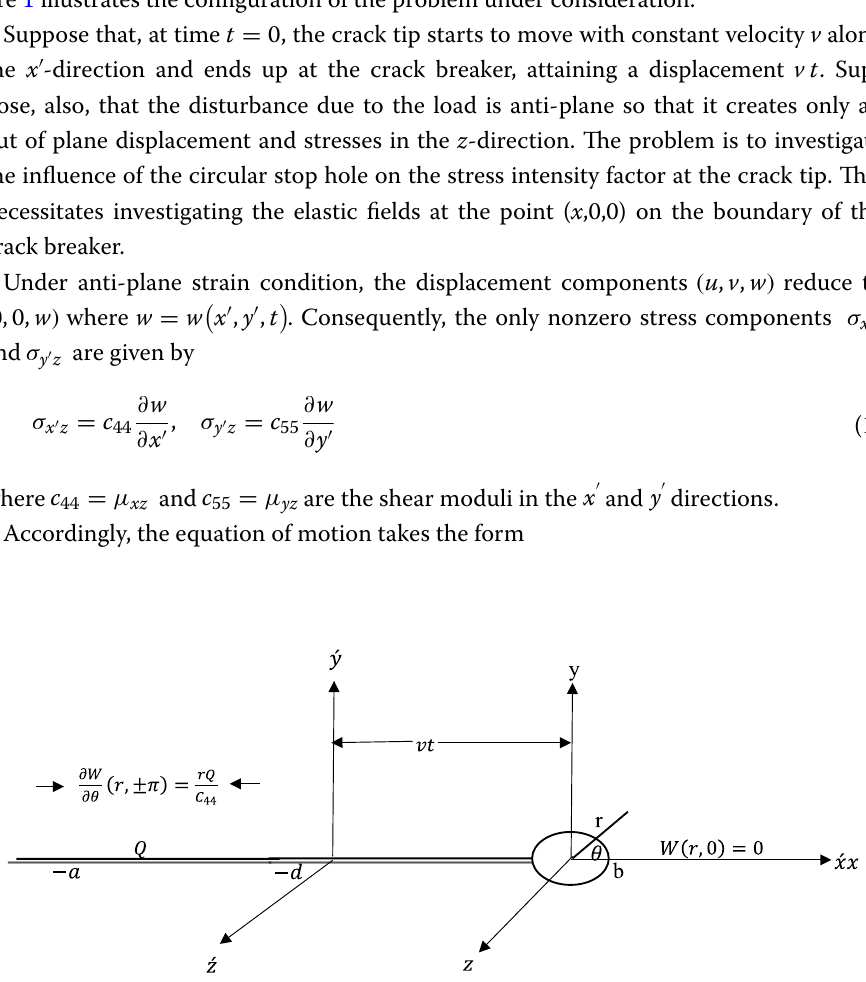
Fig. 1 Geometry and coordinate system of cracked